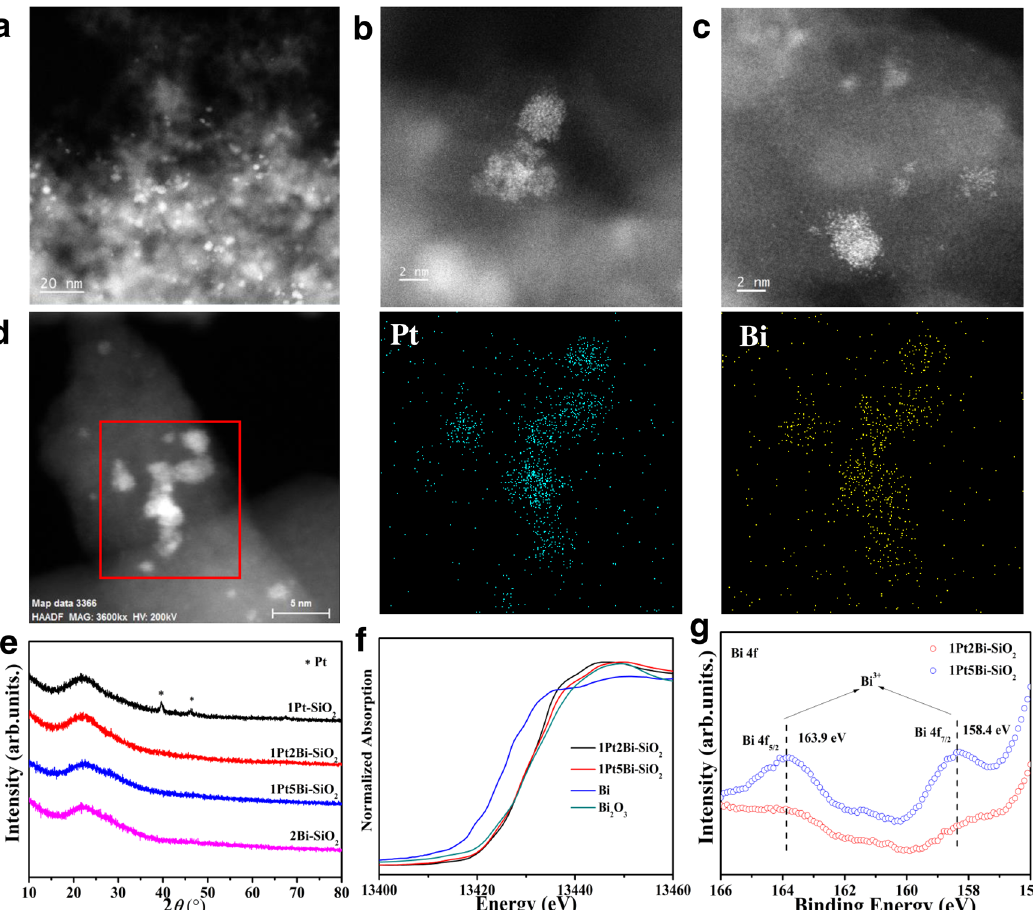
Fig. 4 Structural characterization of used Pt/PtBi-SiO 2 catalysts. Representative aberration-corrected HAADF-STEM images of a – c for used 1Pt2Bi-SiO 2 at different scales and d the corresponding EDS element mapping of used 1Pt2Bi-SiO 2 ; e XRD patterns; Bi L 3 – edge f XANES pro fi les and g XPS pro fi les of used Pt/PtBi – SiO 2